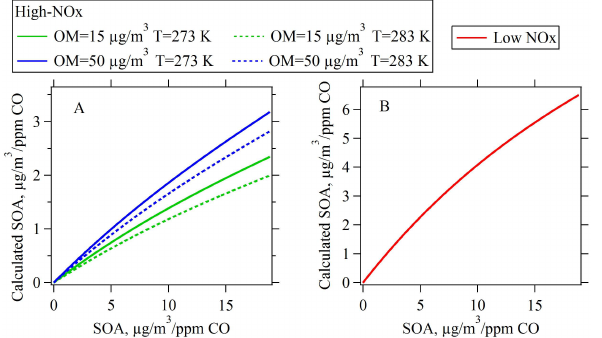
Fig. 7. Correlation of SOA calculated from VOC oxidations and SOA determined from AMS measurements under high-NOx (left) and low-NOx conditions